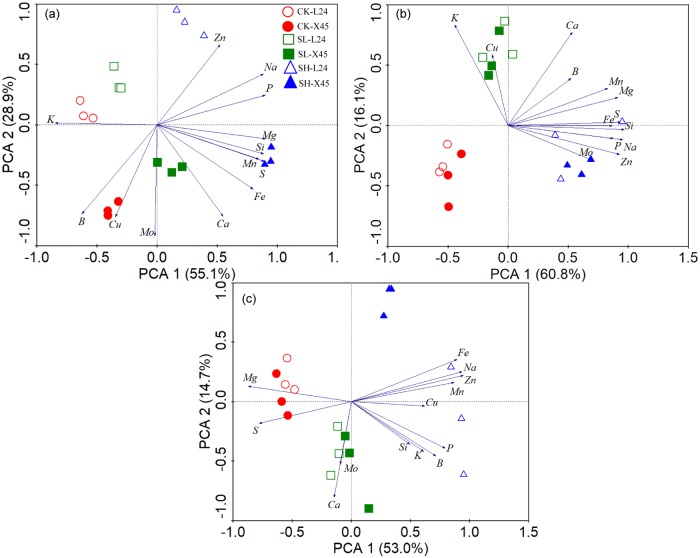
Tissue ionome variation analysis using PCA at the seedling stage and the loadings of elements to the PC1 and PC2.(A) Root ionome variations among samples and the loadings of elements to the PC1 and PC2 in roots; (B) stem ionome variation among samples and the loadings of elements to the PC1 and PC2 in shoots. (C) Leaf ionome variation among samples and the loadings of elements to the PC1 and PC2 in shoots.